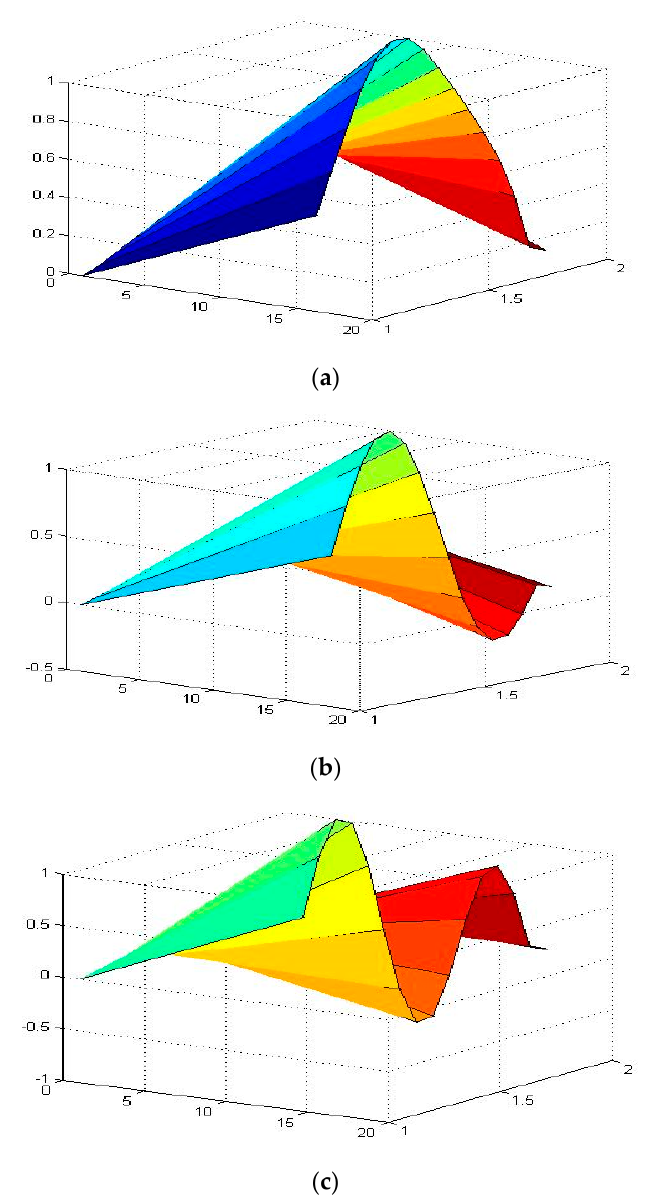
η = 1.5, n = 2 and γ = 0.05.